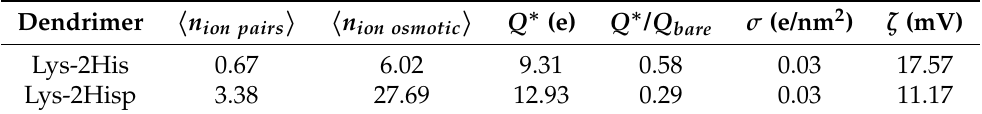
Table 3. The local characteristics of Lys-2His and Lys-2Hisp dendrimers: the average number of ion pairs (cid:104) n ion pairs (cid:105) between counterions and charged groups in dendrimer, the effective dendrimer charge Q ∗ , the relative effective dendrimer charge Q ∗ / Q bare , the surface charge density σ and ζ potential at the average body temperature T = 310